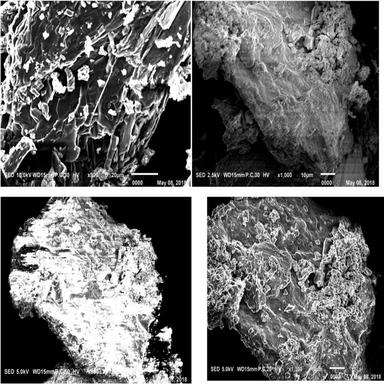
SEM images of the DMPI + β-CyD inclusion complex.